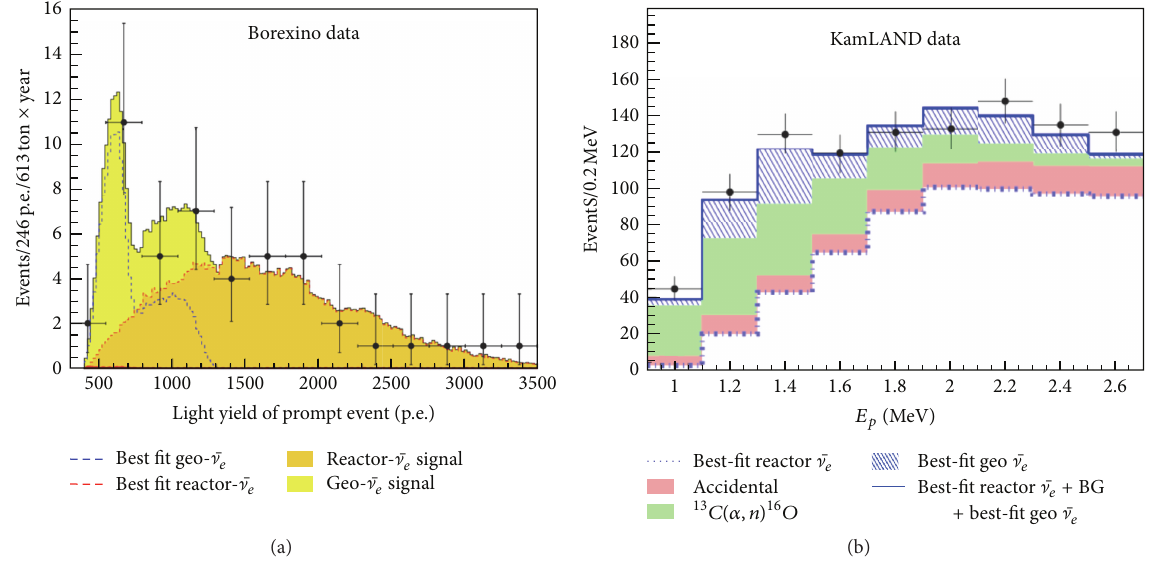
Figure 7: Prompt event energy spectrum measured in Borexino (a) and in KamLAND (b). The Borexino collaboration quotes the prompt event energy as total number of photoelectrons detected by the PMTs, the conversion factor being approximately 500p.e./1 MeV.